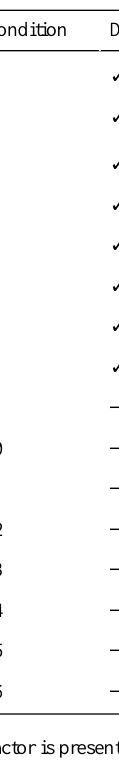
Table 1. Overview of the 16 experimental conditions of the full factorial design—every factor is balanced; therefore, each is present and absent an equal number of